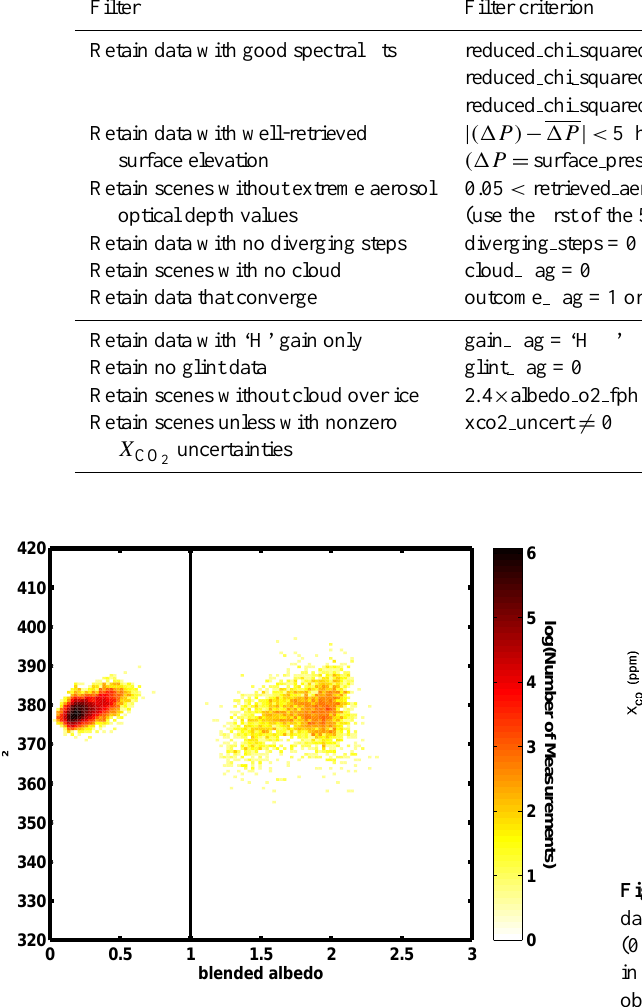
Fig. 4. An illustration of how snowy or icy scenes affect the ACOS- GOSAT data. There are two clear populations of points, delineated by a value of 1 in blended albedo (defined in Eq. 2 of the main text). Points to the left of the line at 1 are not influenced by snow and ice, and they are retained; points to the right are discarded. The colours represent the logarithm of the number of measurements in each 0.7ppm by 0.025 units of blended albedo. The data in this figure are from soundings poleward of 25°S and span 6 April 2009 through 21 March 2011.